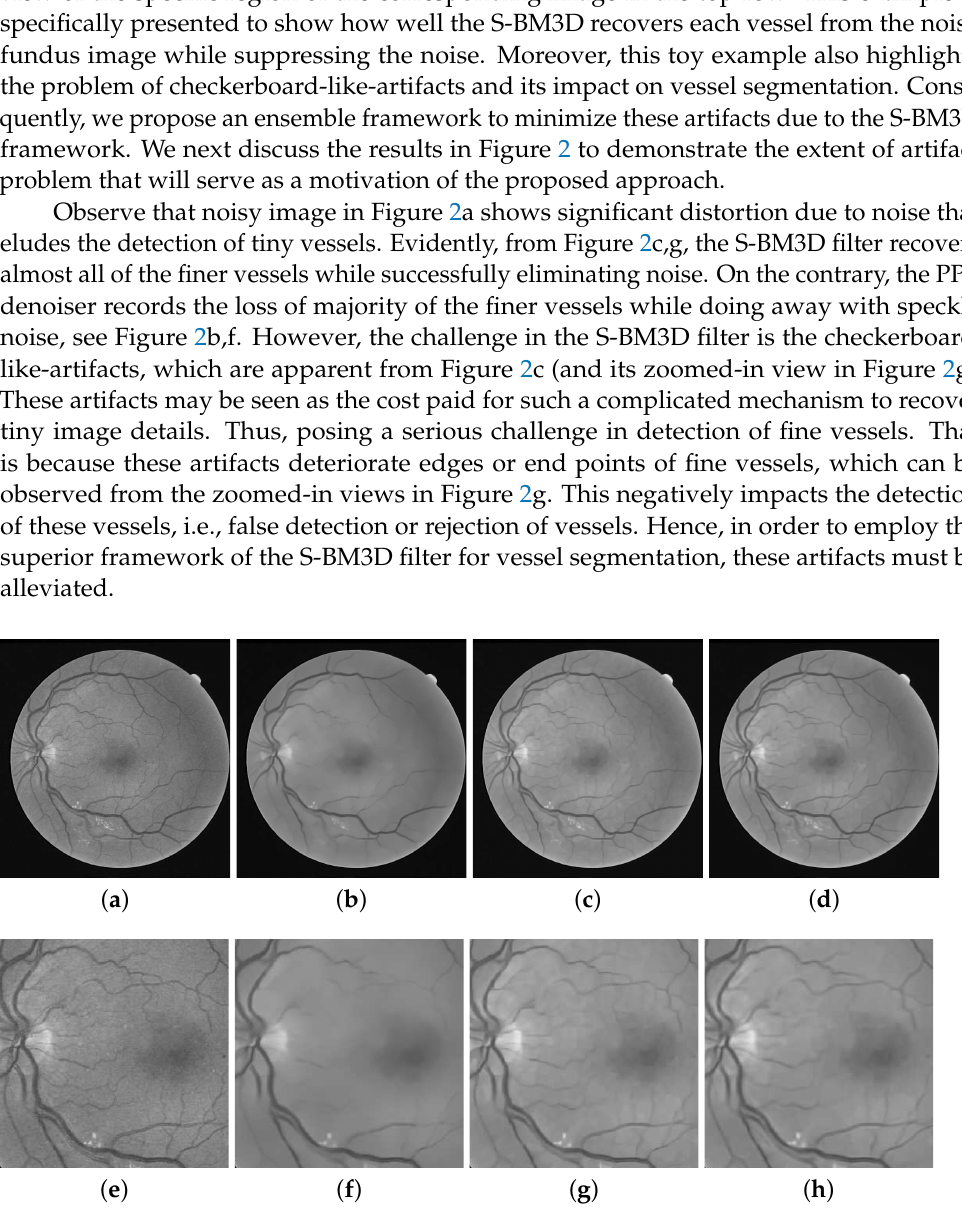
Figure 2. A toy example to motivate our work where the top row shows actual noisy and denoised images from various methods while the bottom row gives zoomed views of the selected region from the images in the top row. First, we show the deterioration caused by noise (in sub-figures a , e ), which show a noisy fundus image from the DRIVE dataset. Subsequently, we show how well the denoised images from the S-BM3D (shown in subfigures c , g ) retain tiny vessels when compared to the PPB denoiser that loses most of the tiny vessels (see sub-figures b , f ). Finally, we shift your attention to the checkerboard artifacts through the zoomed-in views (in the bottom row) in the results of the S-BM3D method and the distortion caused by these artifacts. This motivates our proposed ensemble S-BM3D filter (the results of which are shown in sub-figures d , h ), which successfully suppresses these artifacts while retaining all the